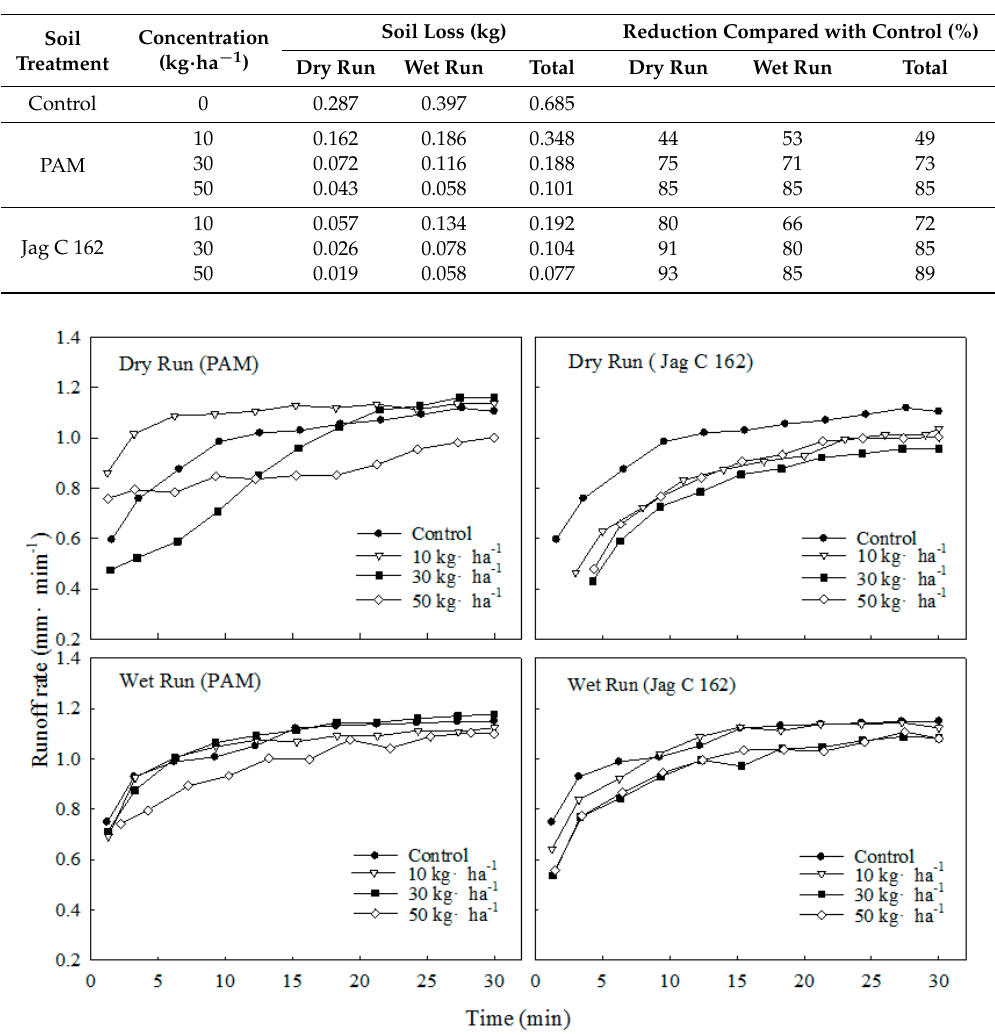
Figure 1. Temporal changes of runoff rates during dry and wet run after polyacrylamide (PAM) and polysaccharide (Jag C 162) treatment.